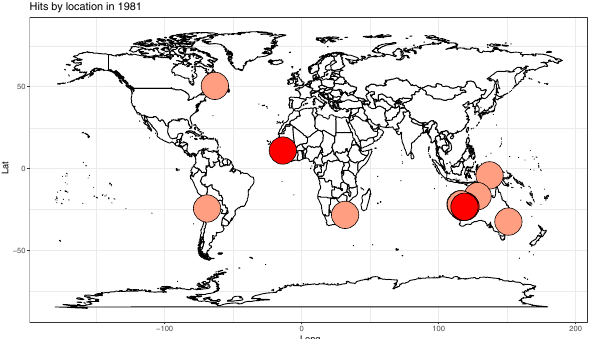
Figure 5. Hits by location for the Rio Tinto portfolio in 1981 for a 30-day, 10-year rainfall event according to the 20CR dataset (dark red corresponds to two exceedances, light red to